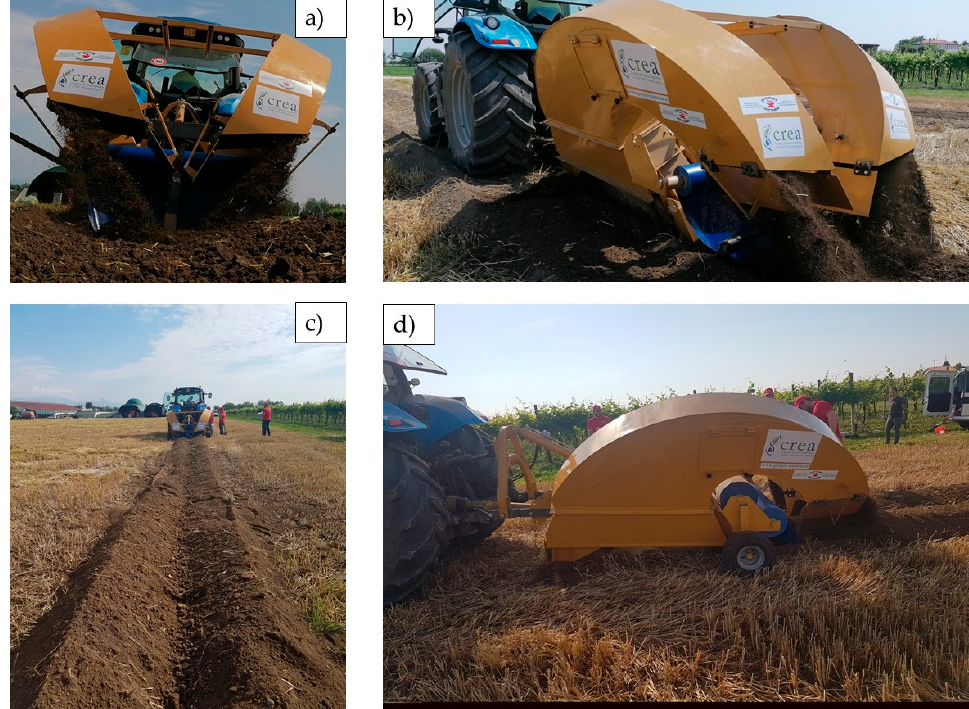
Figure 2. Views of ( a ) the rear of the prototype, where the iron triangle shaped structure is partially visible behind the removable impermeable film, ( b ) the soil being discharged on the film, ( c ) the appearance the SWRS at the end, and ( d ) a lateral view of the prototype.